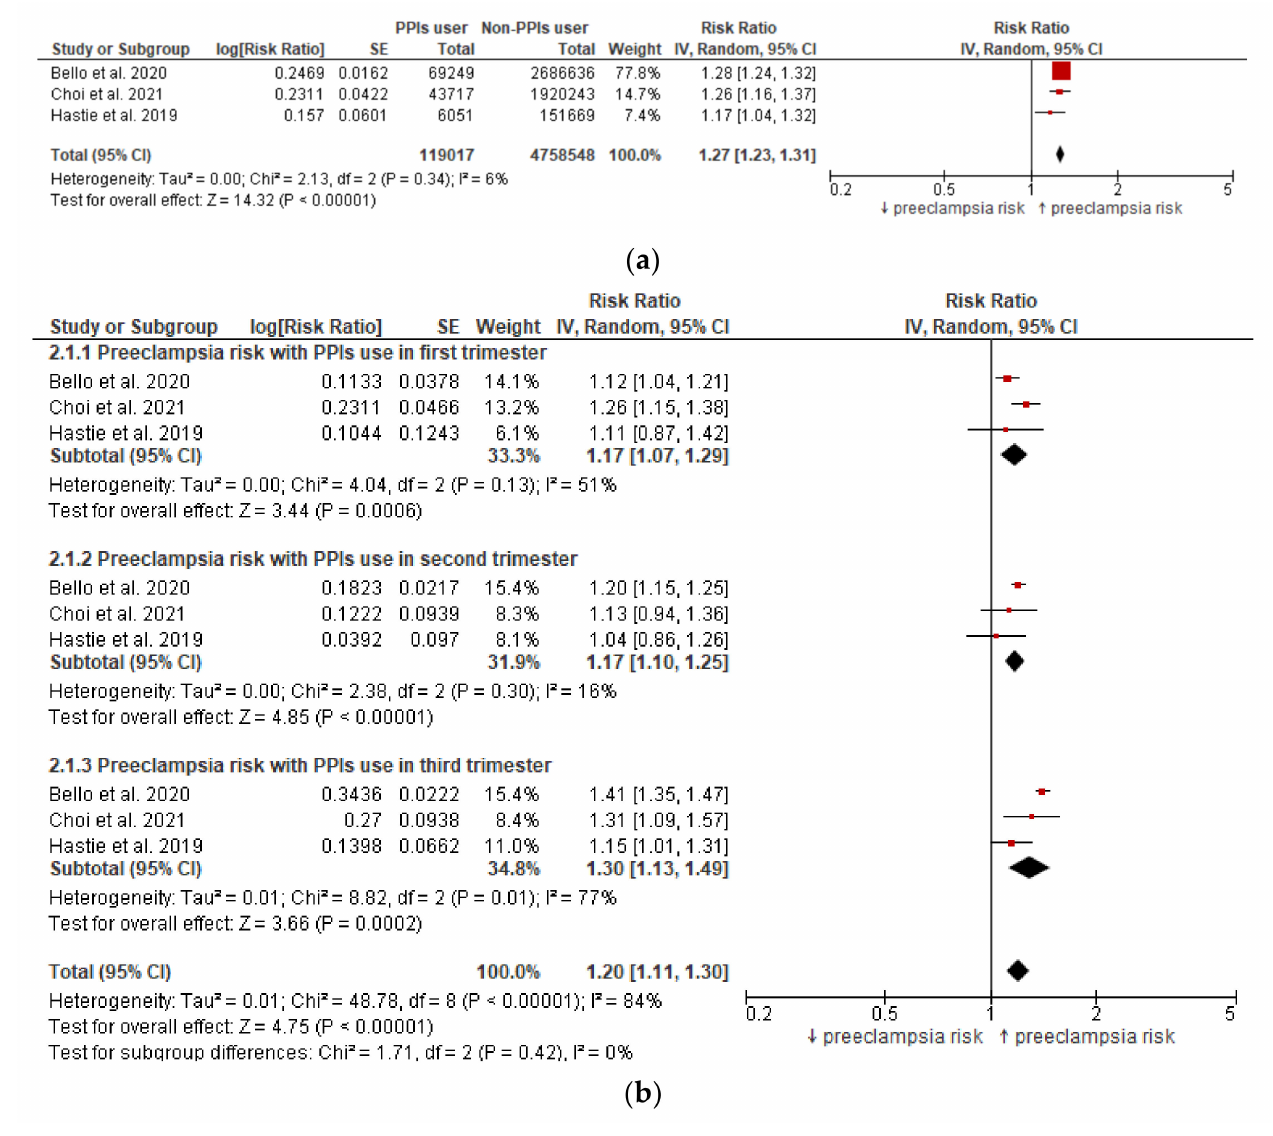
Figure 2. ( a ) Preeclampsia risk in women exposed to PPIs anytime during pregnancy. ( b ) Preeclamp- sia risk in women exposed to PPIs in different trimesters of